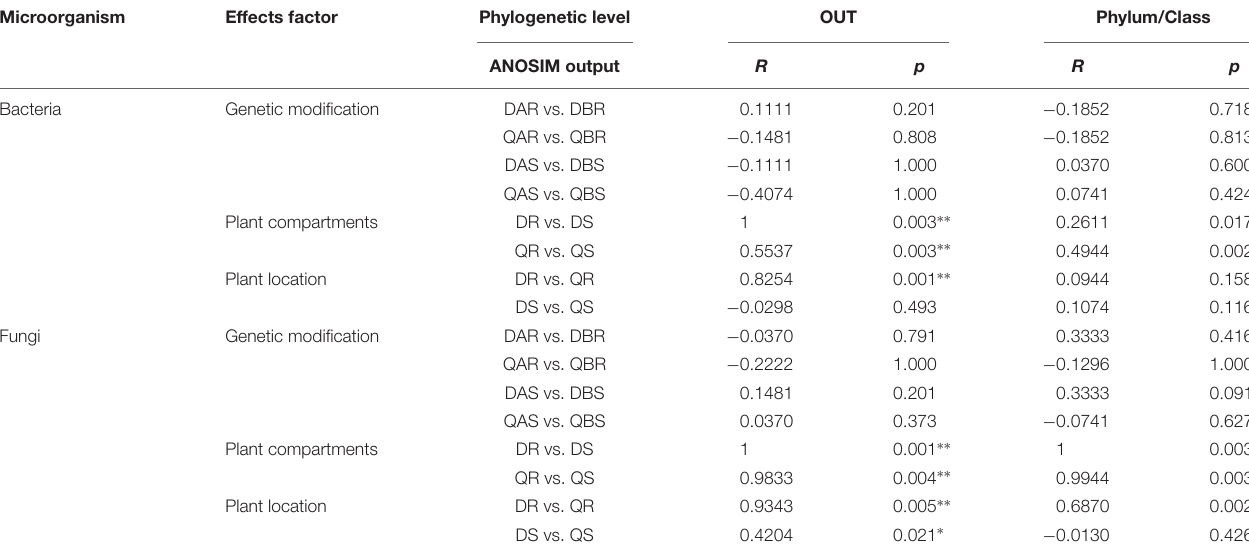
TABLE 2 | Analysis of similarity (ANOSIM).